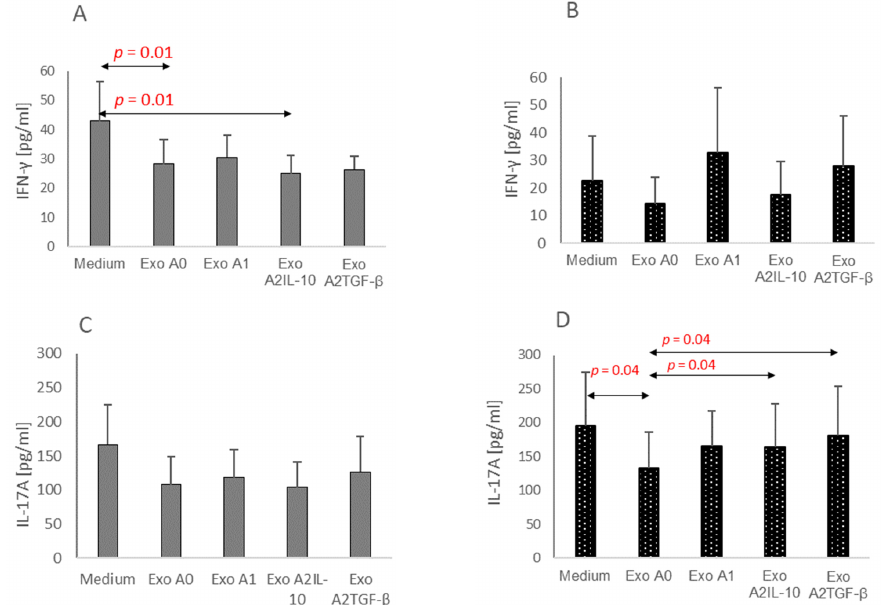
Figure 2. IFN- γ ( A , B ) and IL-17A ( C , D ) production in CD4+ T-cell cultures from multiple sclerosis- affected patients ( A , C ) and healthy donors ( B , D ) (with excluded autoimmune disease). After separa- tion from PBMC, CD4+ T-cells from every donor were isolated by magnetic sorting, and cultured on 48-well culture plates (10 6 cells/well) with exosomes isolated from non-stimulated (Exo A0), pro-inflammatory cytokines stimulated (Exo A1) and anti-inflammatory cytokines (IL-10, TGF- β ) stimulated (respectively Exo A2IL-10, Exo A2TGF- β ) human astrocytes. Data shown as mean ± SEM. Comparisons between variables were made with a Wilcoxon signed-rank test.